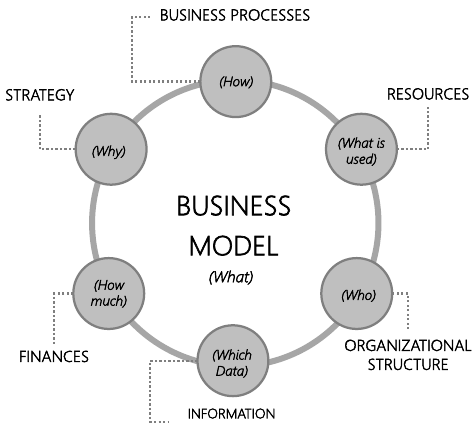
Figure 2. Business model and enterprise